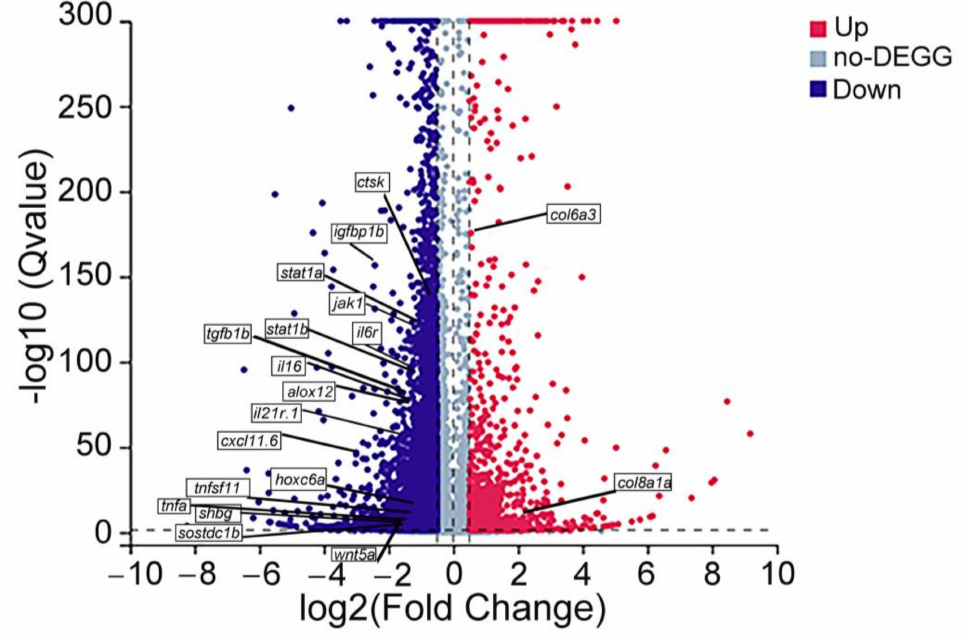
Figure 6. Volcano map of differentially expressed genes (DEGs). The dots represent downregulated (blue) and upregulated (red) DEGs. Genes without difference between the two groups are labeled in purple–gray. The genes in the boxes are reported genes related to bone metabolism.